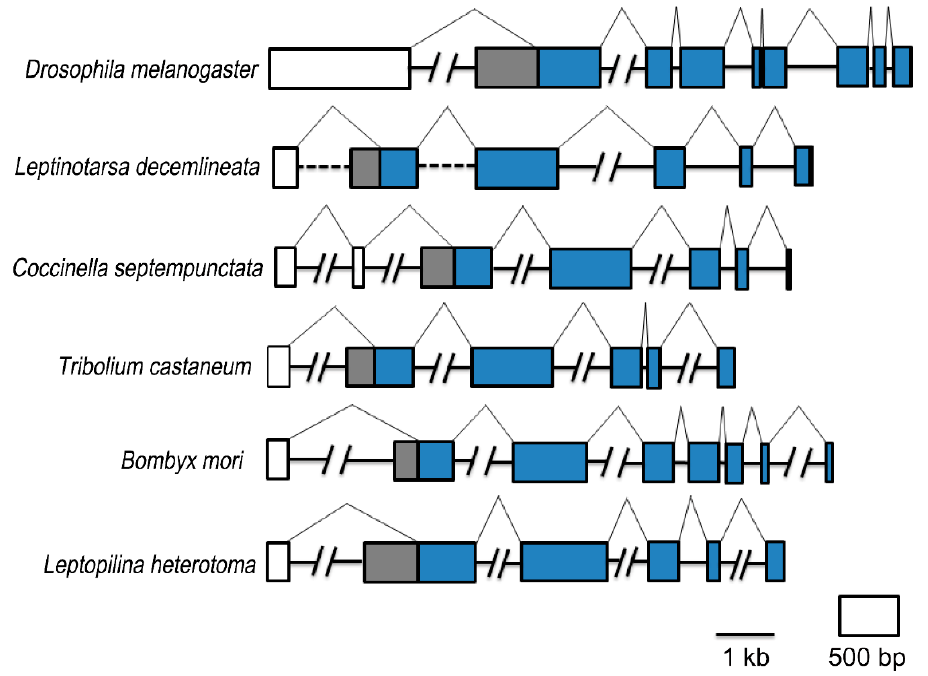
Figure 1. Comparison of FTZ-F1 gene structure in insects. The open reading frame of FTZ-F1 genes from representative Dipteran ( Drosophila melanogaster ), Coleopteran ( Leptinotarsa decemlineata , Coccinella septempunctata , Tribolium castaneum ), Lepidopteran ( Bombyx mori ) and Hymenopteran ( Leptopilina heterotoma ) insects are aligned with genomic DNAs to identify exons and introns. Exons are represented by boxes, while introns and splicing patterns are shown with lines. Exons and introns of 1 kilobase or lower are in scale. The area coding for the isoform-specific parts of the N-terminal domain is respectively highlighted by white ( α FTZ-F1) and gray ( β FTZ-F1) and those encoding both isoforms are marked by blue.